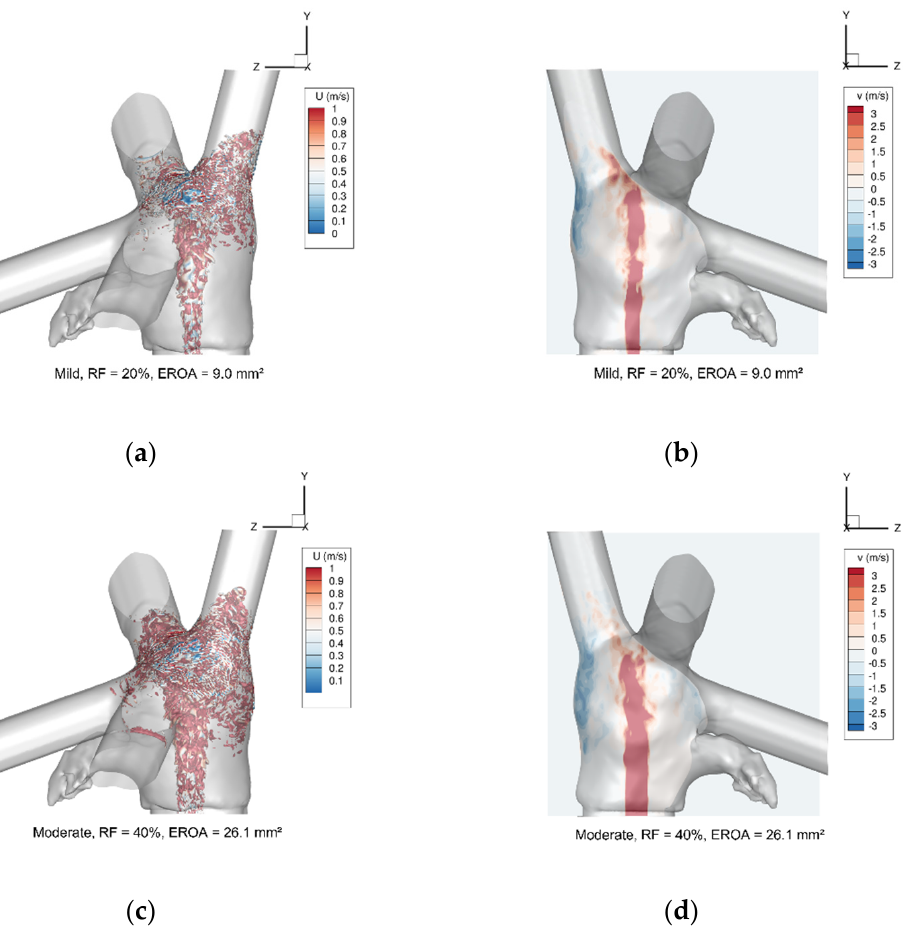
Figure 4. Instantaneous plots for the flow field in the left atrium at 0.105 s: ( a ) the isosurface of Q-criterion colored by the velocity magnitude for the “mild” case; ( b ) the velocity in y -direction in the cross-section along the major axis of regurgitant jet for the “mild” case; ( c ) the isosurface of Q-criterion colored by the velocity magnitude for the “moderate” case; ( d ) the velocity in y -direction in the cross-section along the major axis of regurgitant jet for the “moderate” case.